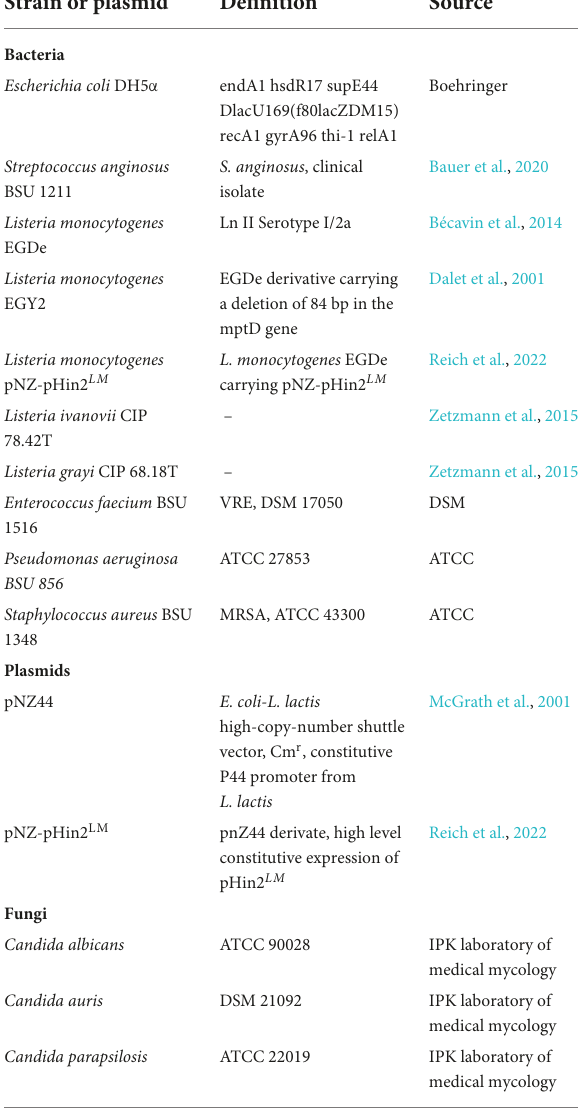
TABLE 1 All bacterial and fungal strains and plasmids used in this